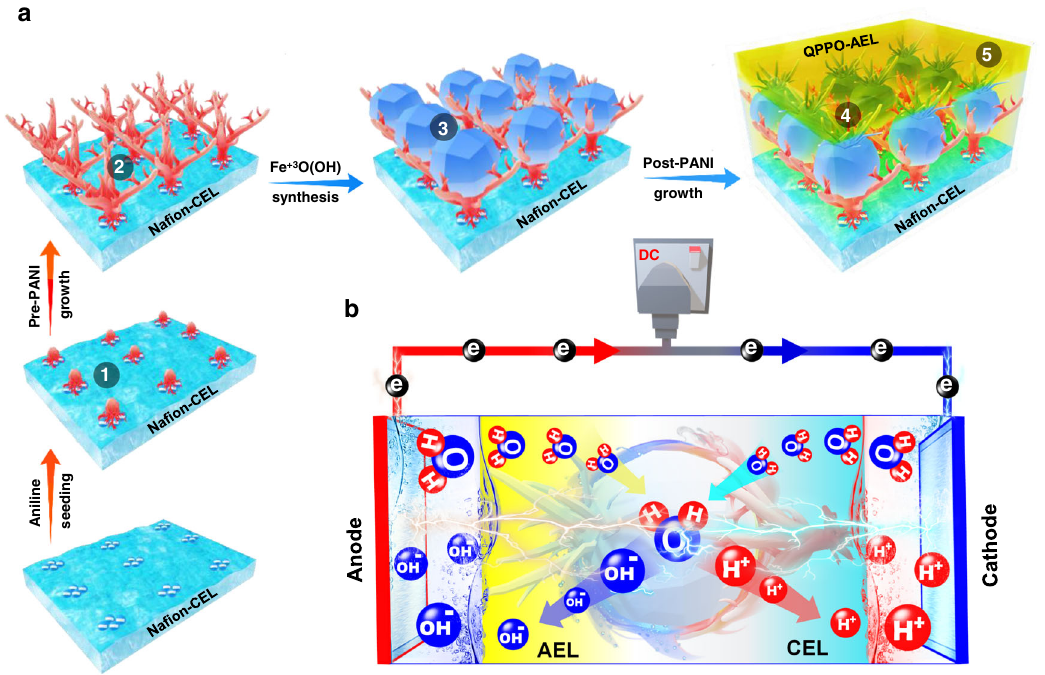
Fig. 1 Simplistic SCBM formation route and water dissociation mechanism. a Schematic showing the four in-situ chemical steps such as ANI seeding (Stage 1), growth of pre-PANI shield (Stage 2), synthesis of the catalyst nanoparticles (Stage 3), growth of post-PANI shield (Stage 4) and the fi fth step for physical infusion of QPPO solution into the catalytic junction to form AEL (Stage 5) sequentially construct an SCBM. b An illustration exhibiting diffusion of water molecules through the cyan CEL and yellow AEL into the catalytic junction, wherein the applied reverse bias electric potential dissociating the feedwater and bringing the produced proton-hydroxide ions out of the catalytic junction.